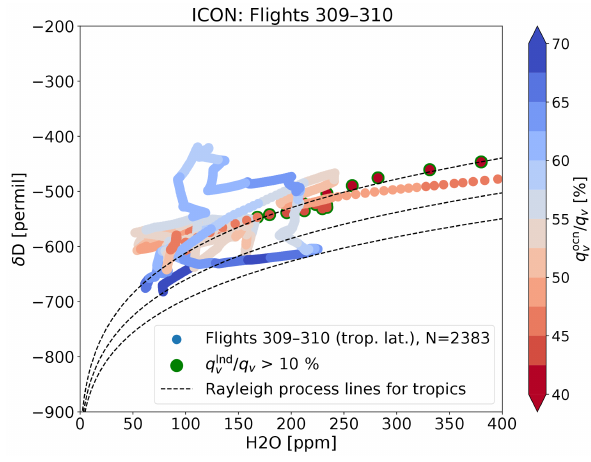
areas. Accordingly, q lnd